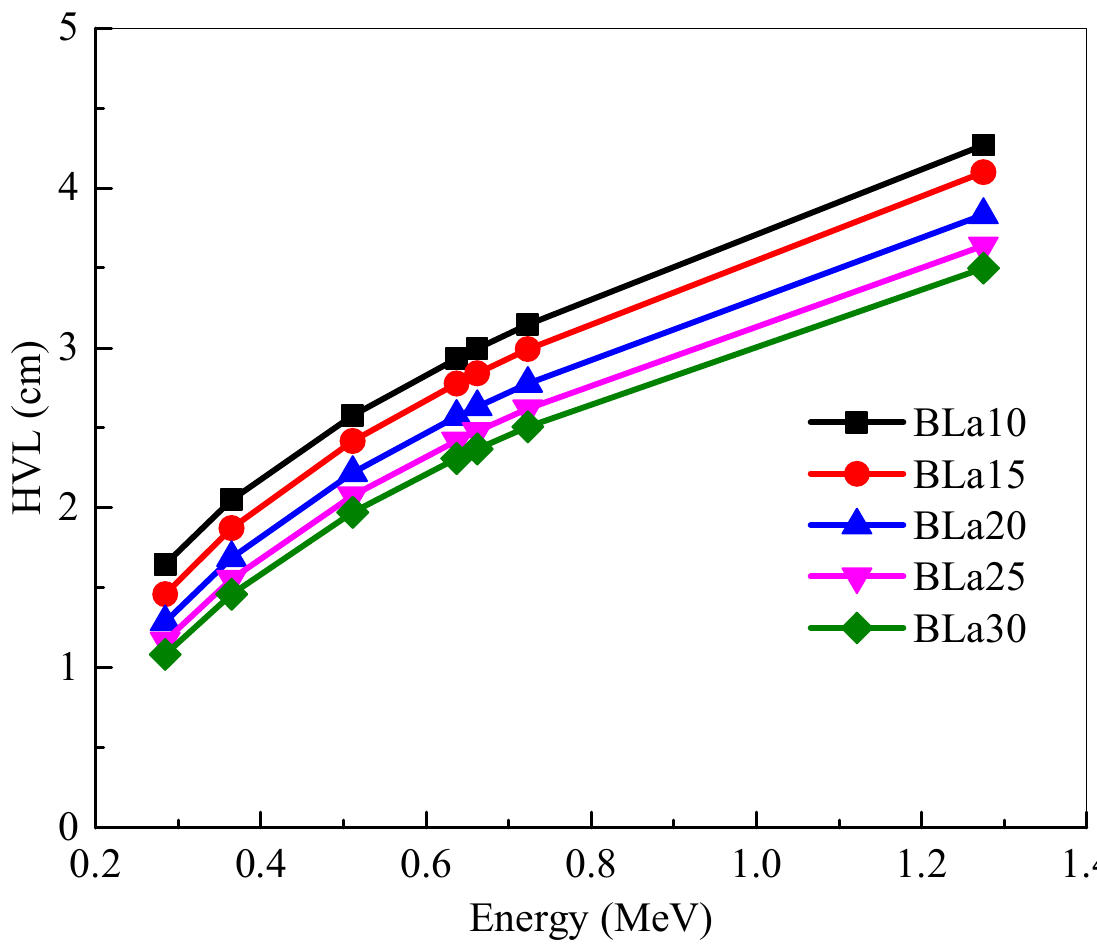
Figure 5. Half value thickness ( HVL ) of the shielding samples at 0.284, 0.3645, 0.511, 0.637, 0.6617, 0.723 and 1.275 MeV.